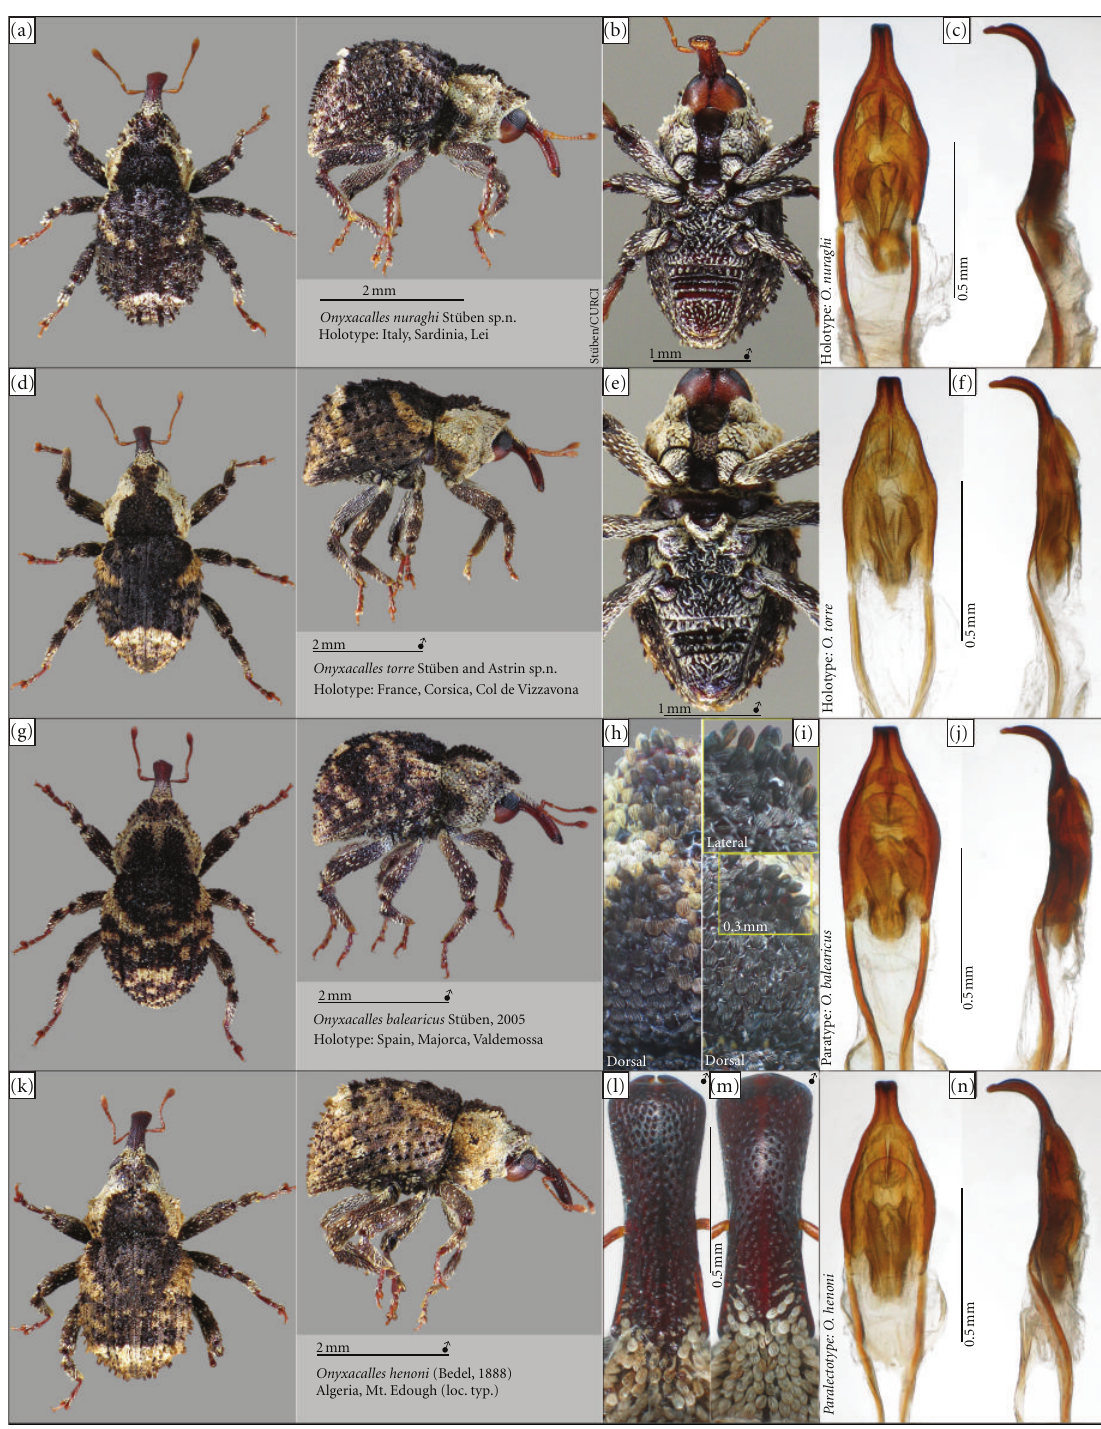
Figure 5: (a)–(c) O. nuraghi sp.n.—habitus (dor./lat./ven.), aedeagus (ven./lat.). (d–f) O. torre sp. n.—habitus (dor./lat./ven.), aedeagus (ven./lat.); (g, j) O. balearicus —habitus (dor./lat.), aedeagus (ven./lat.); (k, n) O. henoni —habitus (dor./lat.), aedeagus (ven./lat.). By comparison, bristle of pronotum— O. balearicus (h) versus O. nuraghi (i); rostrum— O. henoni (l) versus O. torre